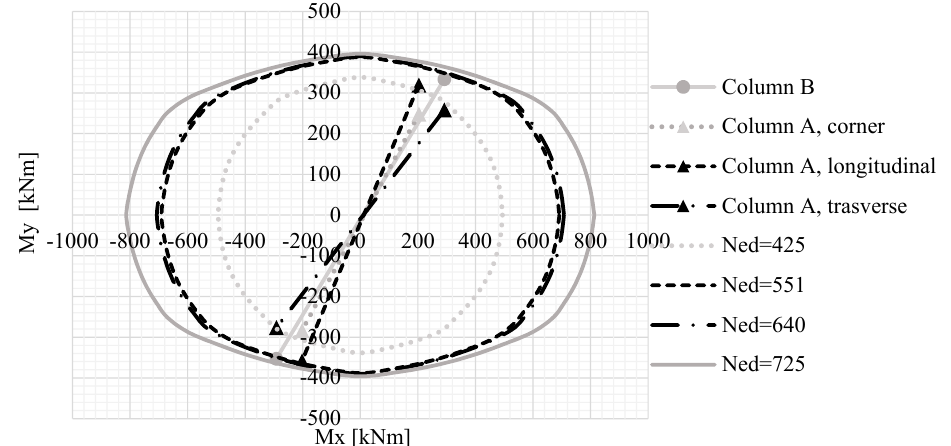
Figure 22. Resistance domains of reinforced columns following the first hypothesis of intervention. In Figure 23, the pushover curves obtained after intervention are represented and compared with the pre-intervention ones.